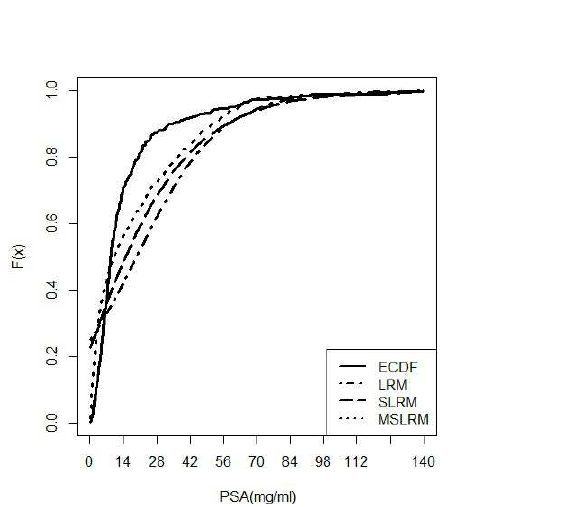
Figure 2 – ECDF of the data set1 and fitted regression models - LRM, SLRM and MSLRM